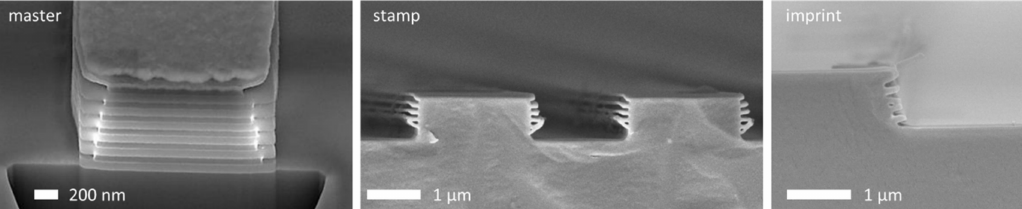
Figure 8. SEM cross-sectional images of the multilayer structure sequence from the master structure in Si (left) over the stamp in NILCure ® JR5 (center) and the imprinted structures in NILcure ® JR5